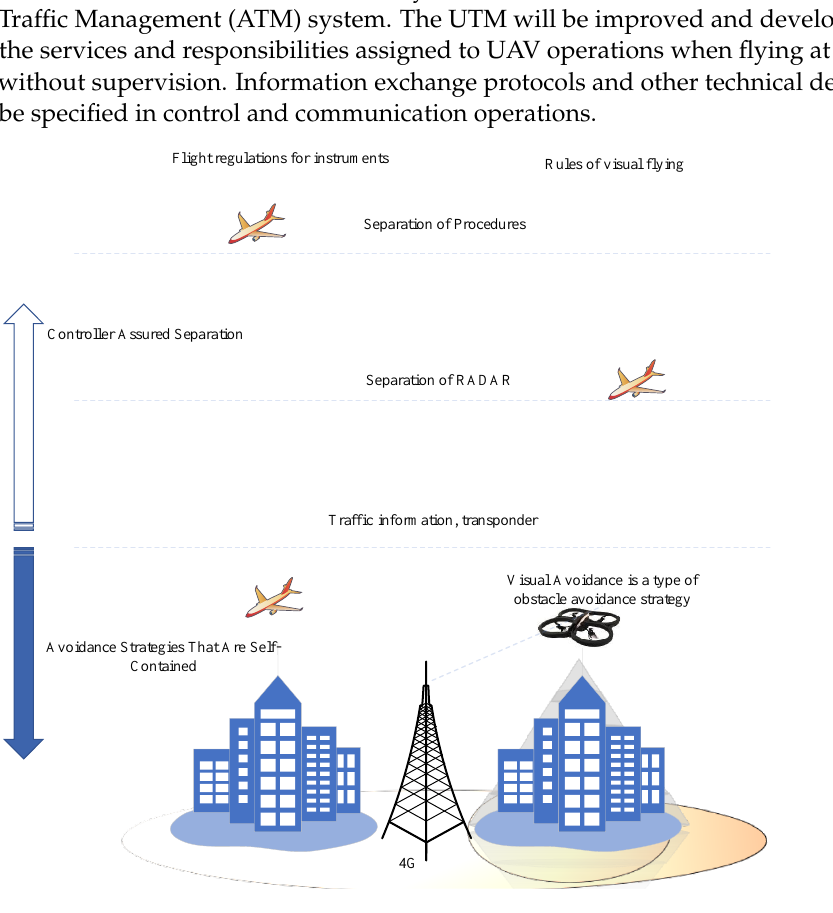
Figure 1. Details of the task confronting administrative bodies and the activity required for a com- prehensive UTM framework. comprehensive UTM